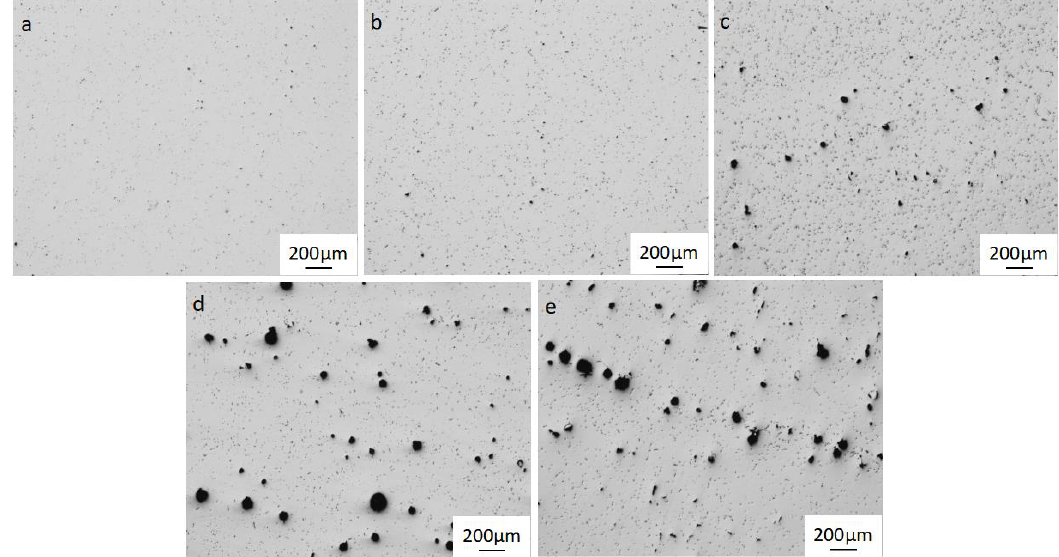
Figure 3. Pores of deposits with different heat input. ( a ) 30 J/mm; ( b ) 60 J/mm; ( c ) 90 J/mm; ( d ) 120 J/mm; ( e ) 150 J/mm.